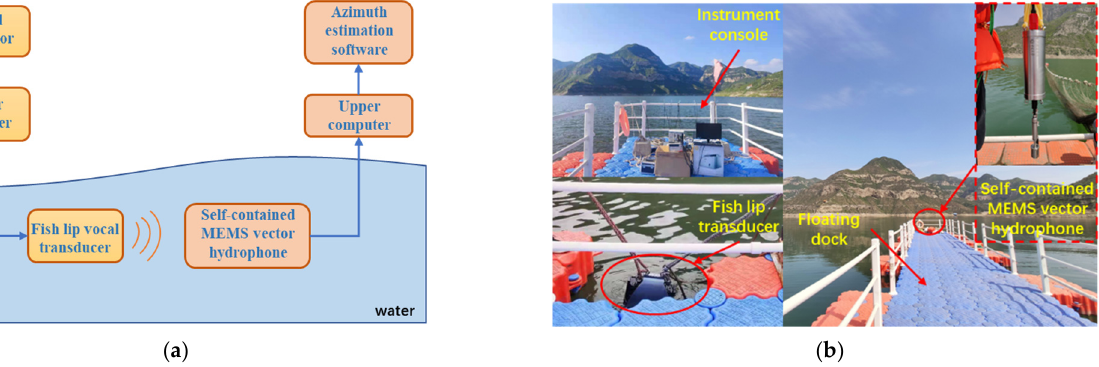
Figure 14. ( a ) Schematic diagram of experimental process; ( b ) diagram of experimental site.